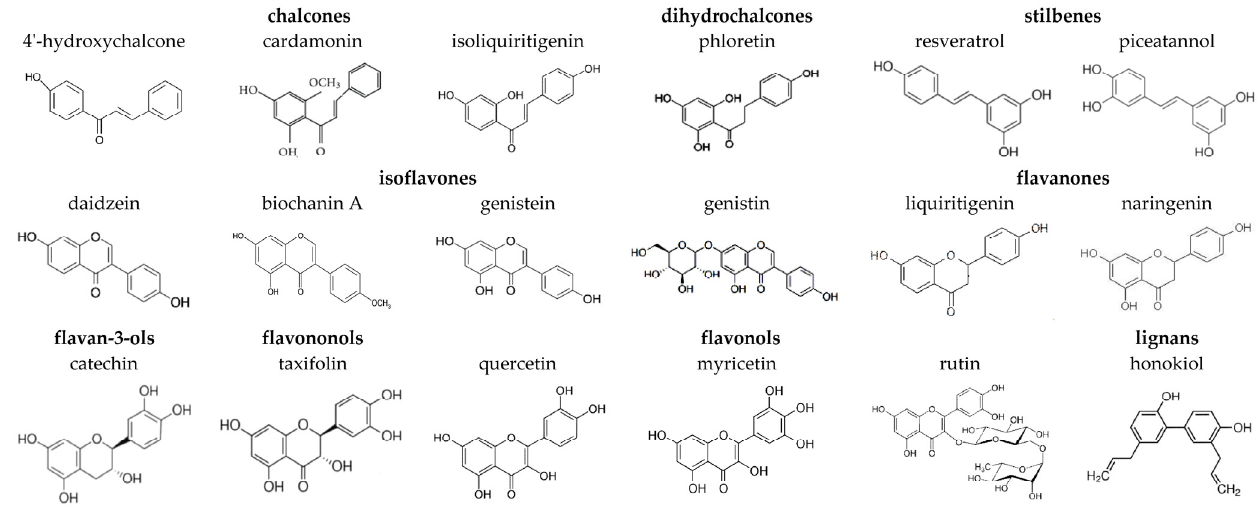
Figure 1. Chemical structures of tested plant polyphenols.